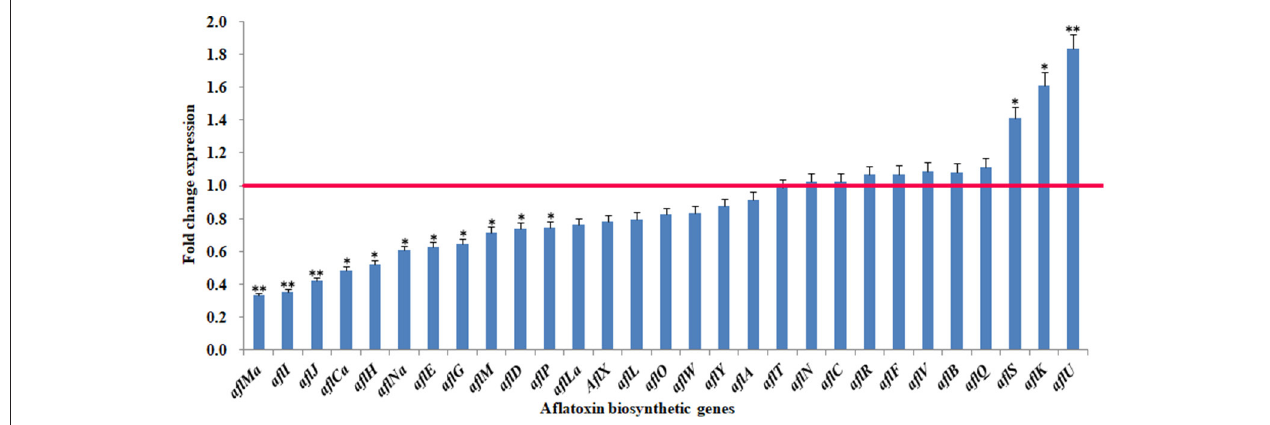
FIGURE 2 | Fold change expression of genes belonging to the cluster responsible for aflatoxin biosynthesis in response to eugenol at 0.80mM. Red line represents control expression level. * p -value < 0.05; ** p -value < 0.01.